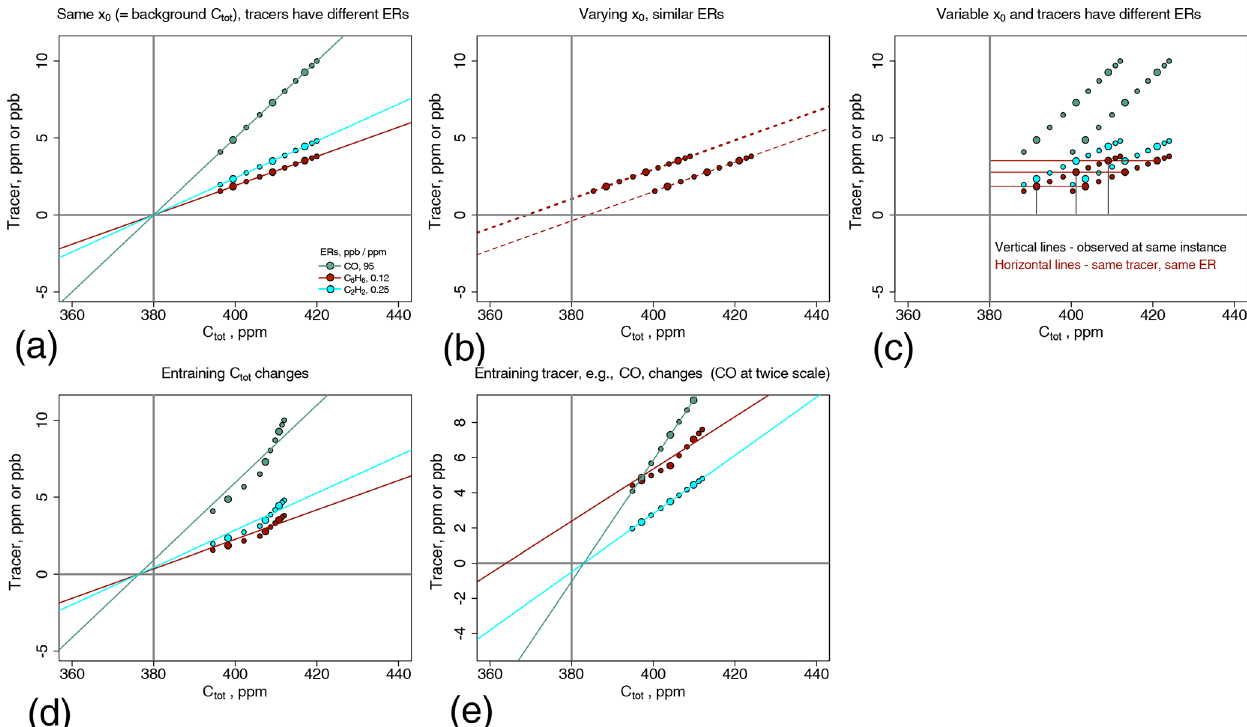
Figure 6. (a) Simulated dilution of three different fire tracers’ EnRs as shown, and with environmental x E of 380ppm. These are nominally CO, benzene, and ethylene. Background concentrations of the tracers have been subtracted. C burn is measured from the y axis, where C tot has the value of 380ppm. Larger dots highlight equivalent degrees of dilution. (b) Simulated dilution of one tracer, nominally CO above background, with different background x E . Backgrounds are illustrated by the x intercepts. (c) Simulation of three tracers, varying EnRs and varying backgrounds (deducible from the x intercepts). Thin lines emphasize similar constant y values with different backgrounds and constant x 0 values with varying EnRs. (d) Simulations like in panel (a) but with a change in the x E entrained x 0 = C burn background from 395 to 375ppm at the time of the eighth dilution step. A single applicable background value of ∼ 378ppm is a linear interpolation between 395 and 375ppm. (e) Simulation where background x E remains constant but background CO changes by 1.5ppb during the same time (CO drawn at twice the height for